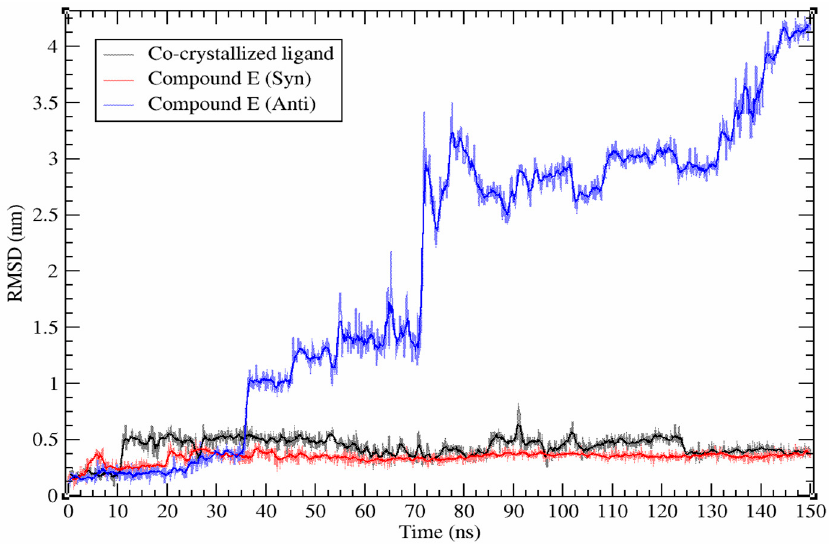
Figure 5. Root mean square deviation (RMSD) plot of HI 5 ( syn and anti -isomers) and co-crystallized ligand during simulations.